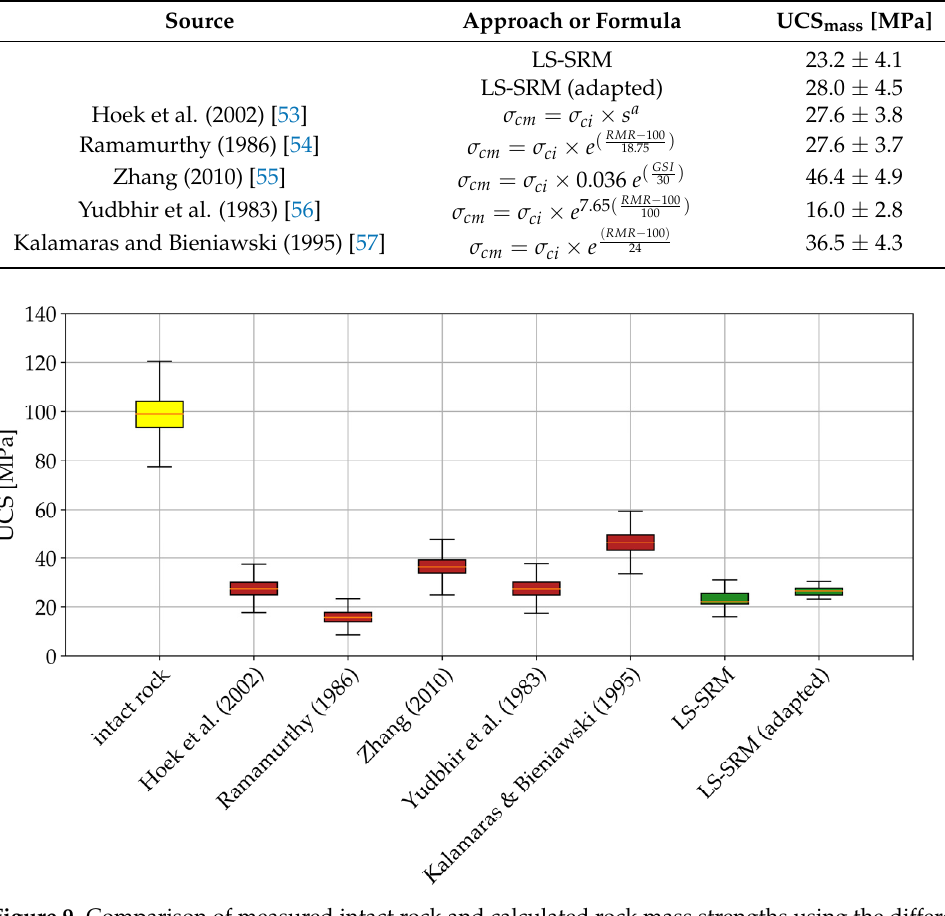
Figure 9. Comparison of measured intact rock and calculated rock mass strengths using the different upscaling approaches (e.g., [53–57]).